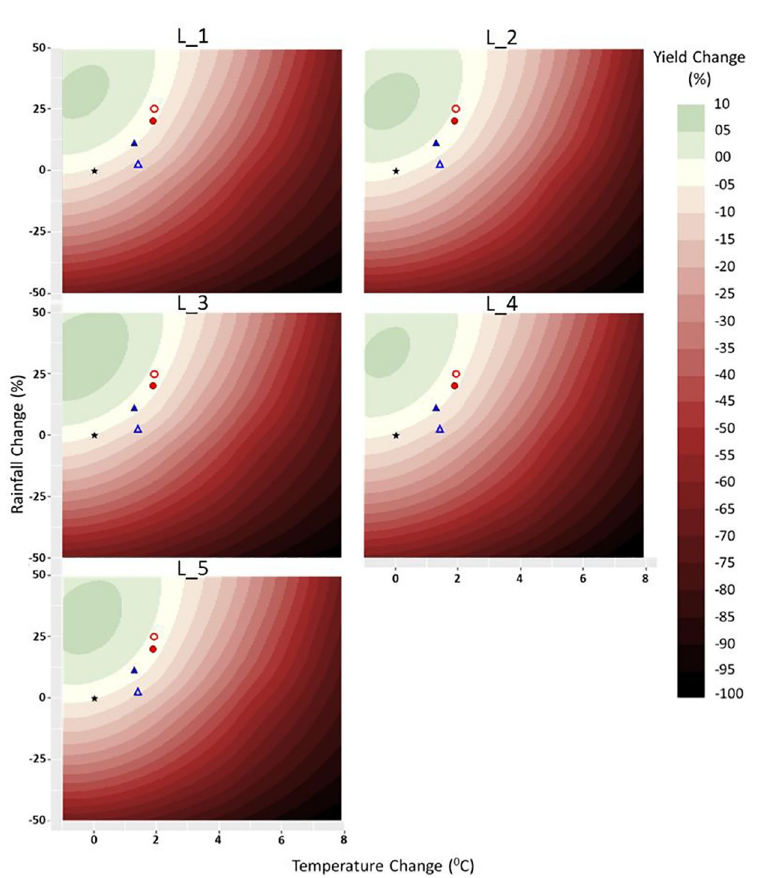
Fig 2. Yield sensitivity of five Proso millet accessions to rainfall and temperature changes in Dry Zone, Sri Lanka under C3MP and mid-century climate, where filled blue triangle is mean annual rainfall (P) and temperature (T) changes for RCP4.5, red dot is annual P and T change for RCP8.5, open triangle is mean Proso millet growing seasonal P change, open dot is mean Proso millet growing seasonal T change and star is yield sensitivity at zero P and T change.